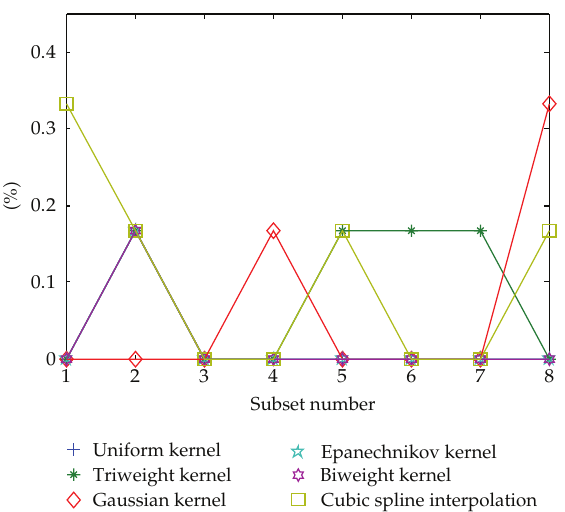
Figure 6: Subset numbers analysis of some forecasting